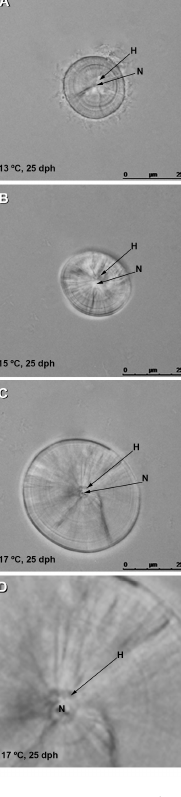
Figure 3. Sagittal otoliths of European sardine Sardina pilchardus (Walbaum, 1792) larvae reared under 13 ◦ C ( A ), 15 ◦ C ( B ) and 17 ◦ C ( C ) and ( D ) for more detail of the nucleus and hatch check at 25 days post-hatching (dph). Legend: H–hatch check.